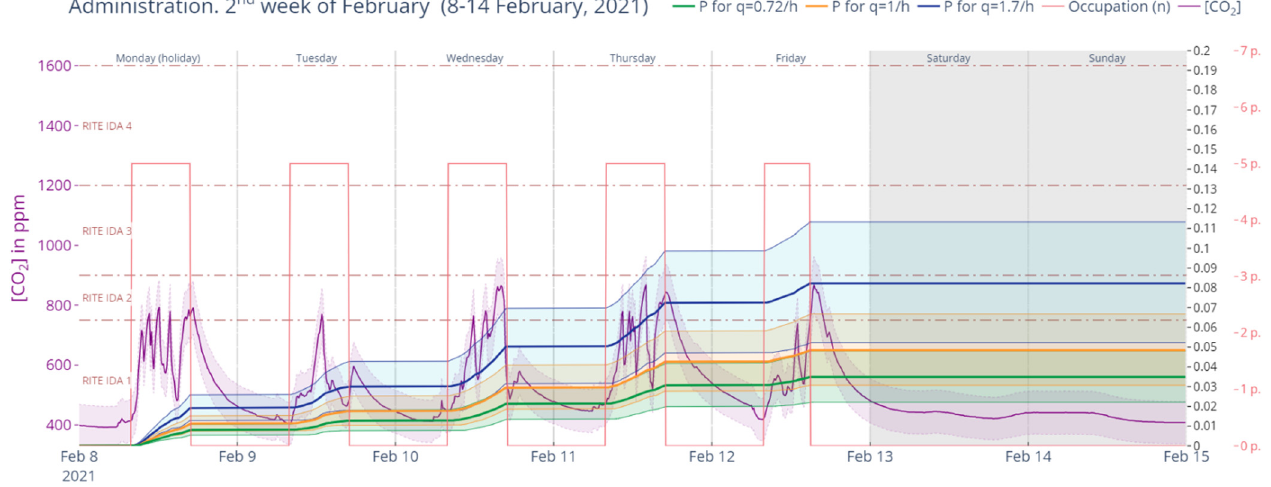
Figure 25. Retrospective analysis of secondary infection risk during the second week of February, 2021 (Phase II). Source: authors.